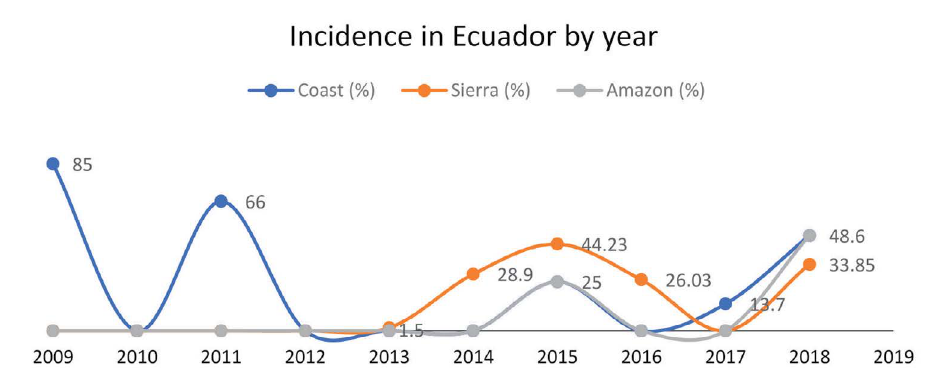
Fig. 1. Salmonella incidence level by